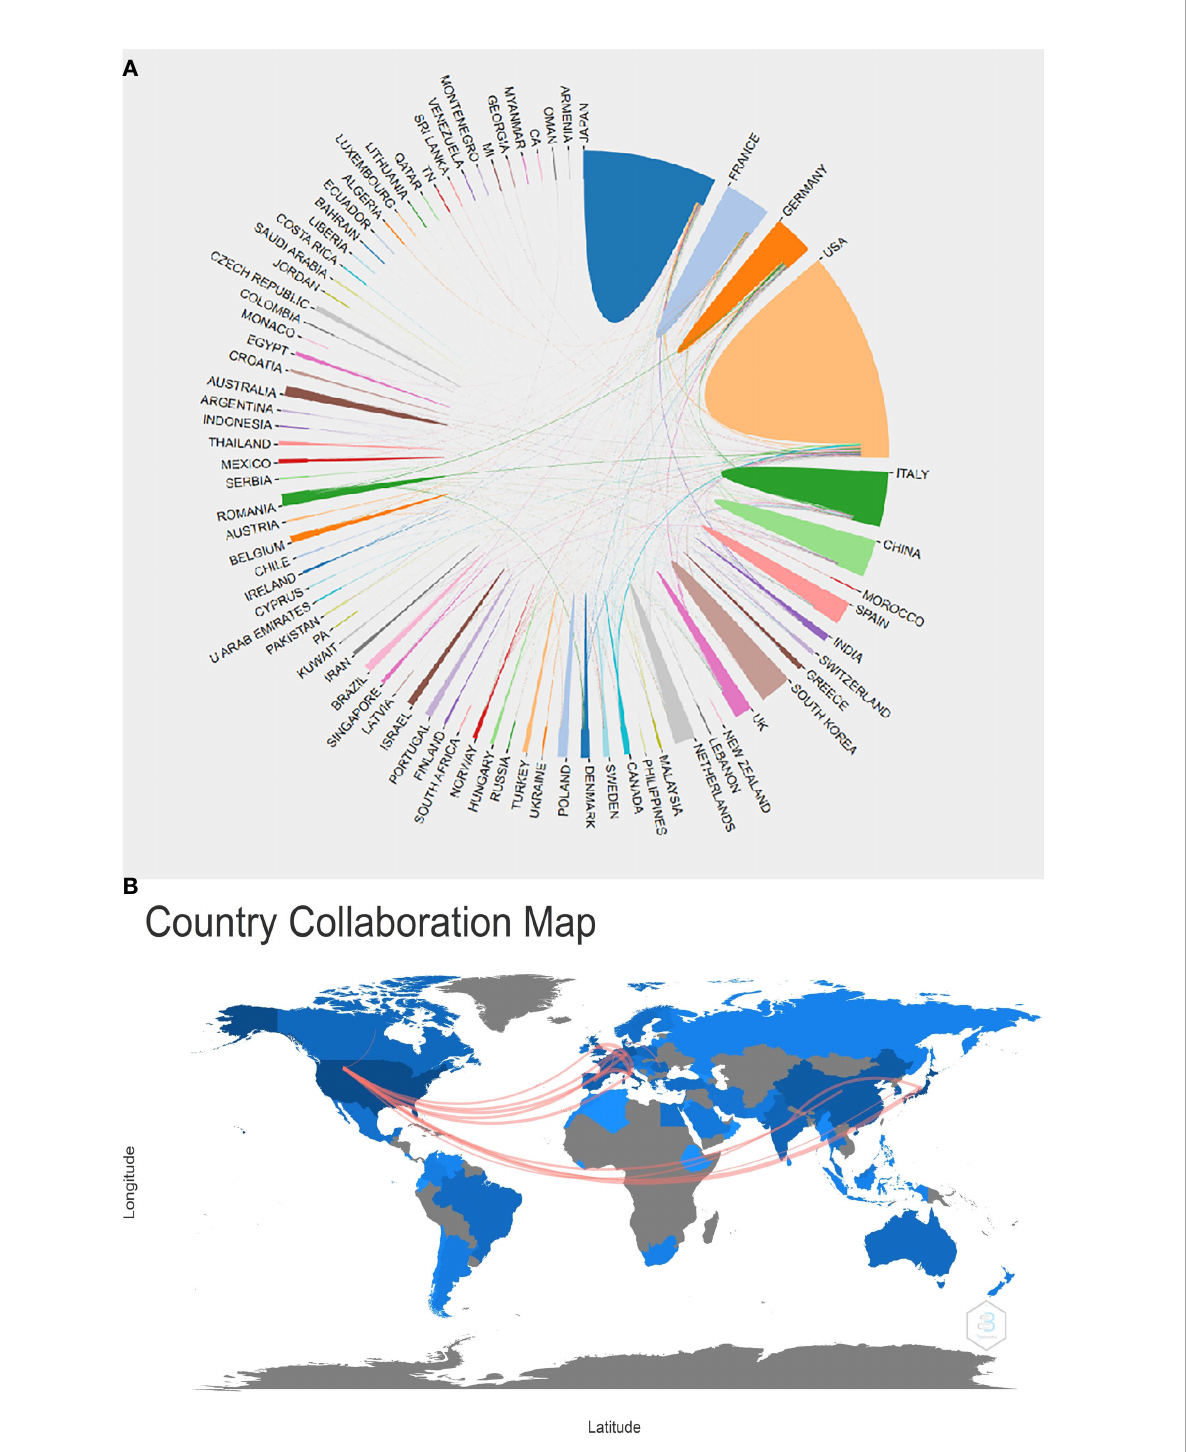
FIGURE 4 Country/region analysis. (A) The cooperation of countries/regions in this fi eld from 1984 to 2021. (B) Country collaboration map in this fi eld from 1984 to